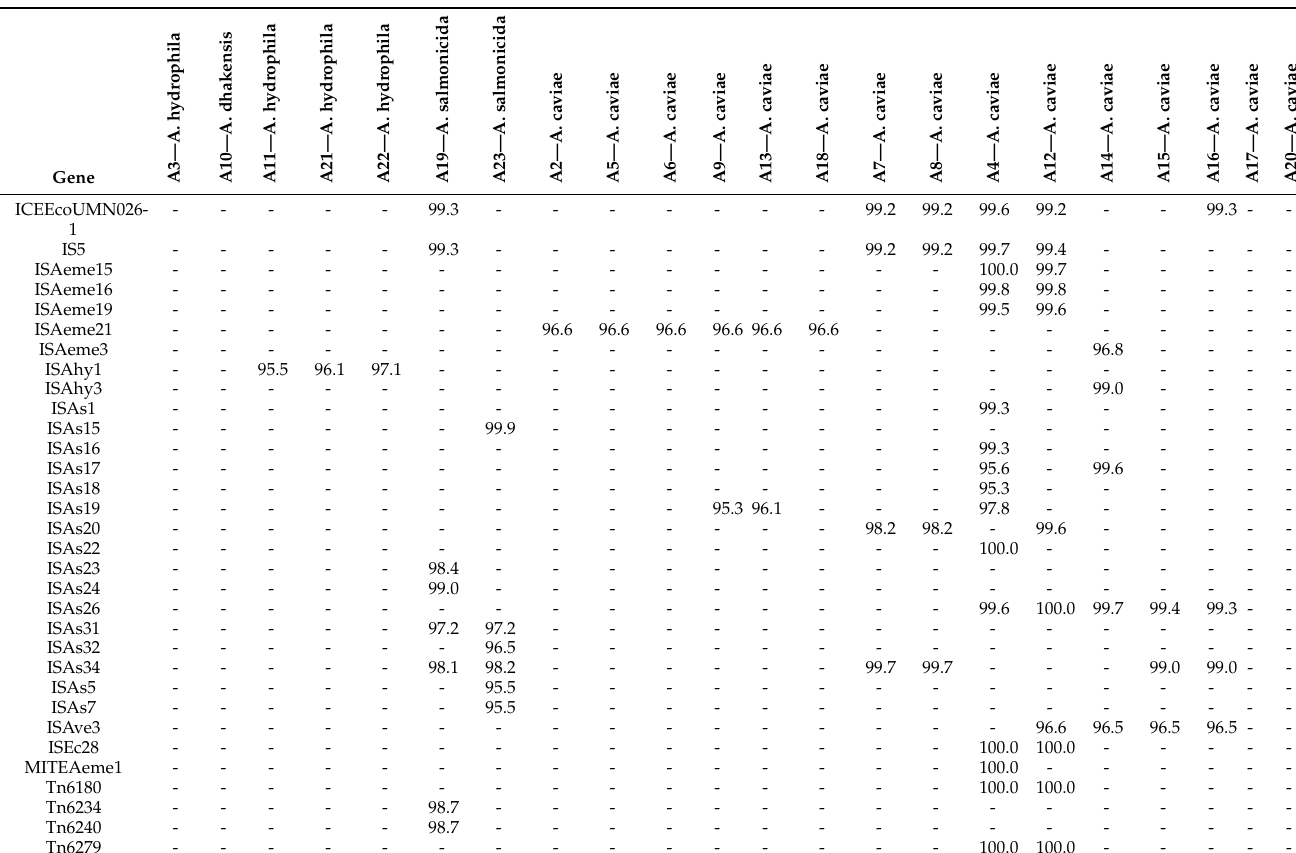
Table 3. Percent alignment of genes identified in Aeromonas hydrophila , Aeromonas salmonicida ,